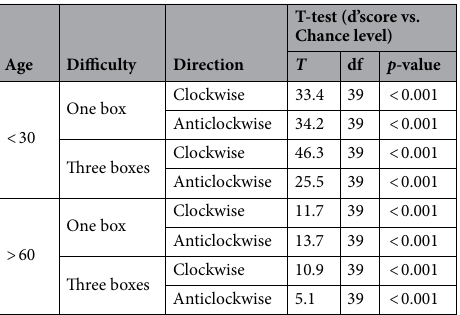
Table 3. T-test was conducted to evaluate differences between the discriminability (d’) index and the chance level, as a function of Age (young, < 30 years, and older, > 60 years), Difficulty (one box and three boxes), and Direction (clockwise and anticlockwise). df, degree of